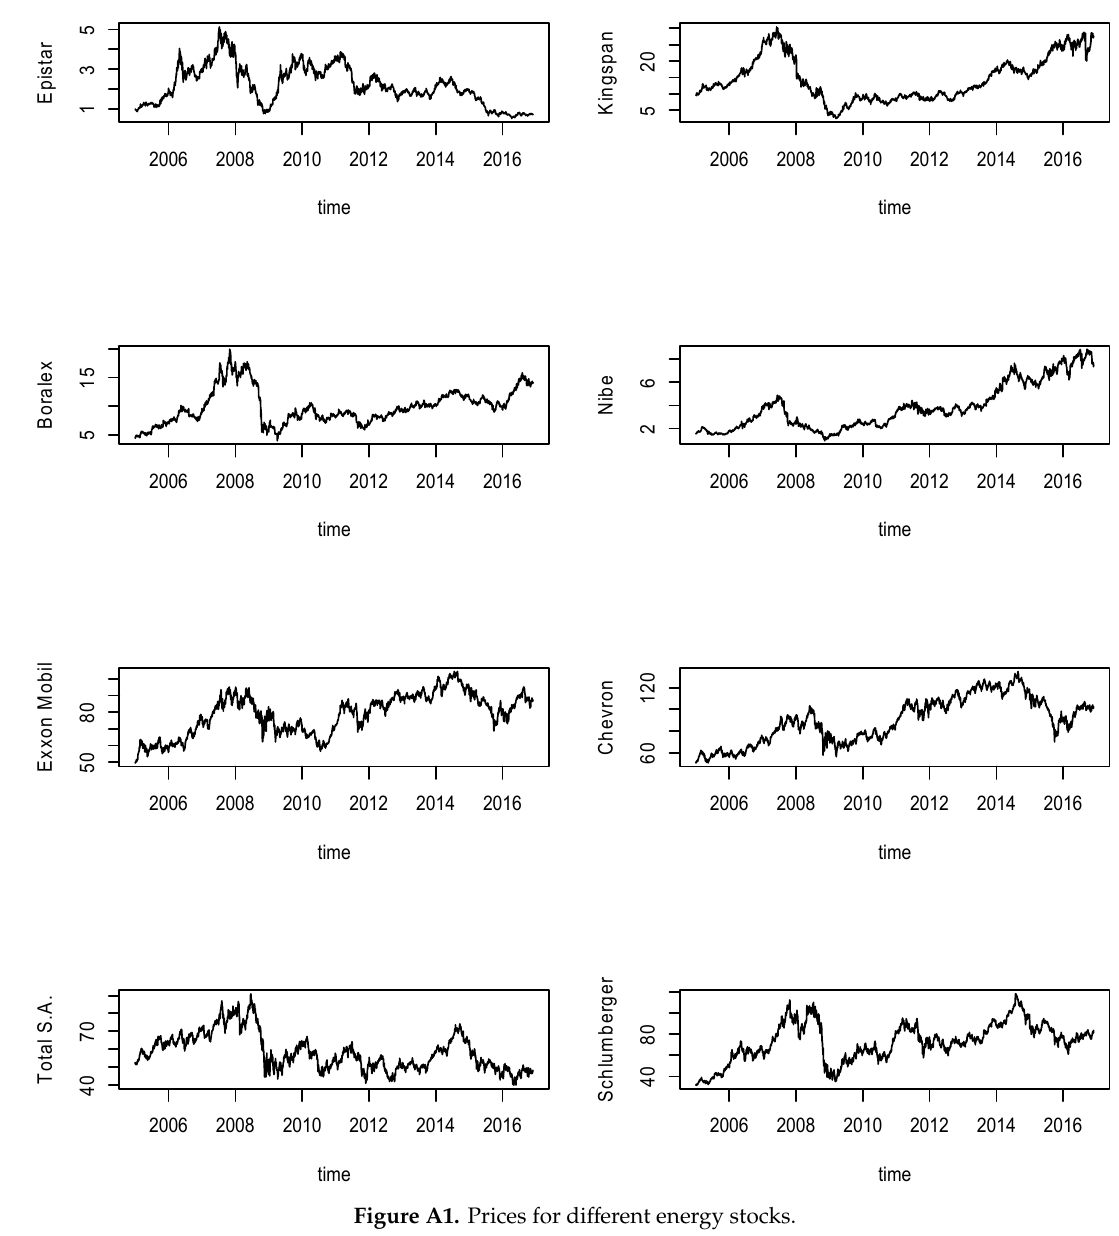
Figure A1. Prices for different energy stocks.